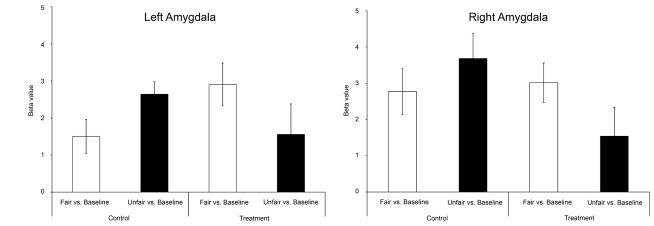
Parameter estimates in the right and left amygdala.Left amygdala: placebo fair, 1.50±0.46 (mean ± standard error of the mean); placebo unfair, 2.64±0.34; oxazepam fair, 2.91±0.58; oxazepam unfair, 1.56±0.82. Right amygdala: placebo fair, 2.77±0.63; placebo unfair, 3.69±0.68; oxazepam fair, 3.02±0.54; oxazepam unfair, 1.55±0.79.